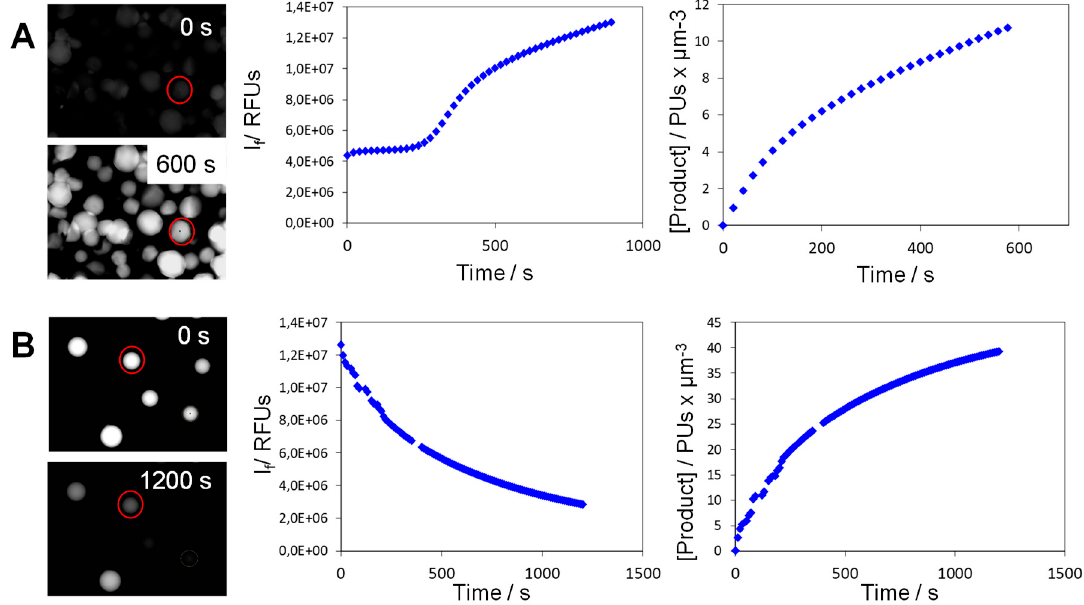
Figure 1. ( A ) Single-particle time courses extracted from microcopy images of agarose microbeads co-immobilizing formate dehydrogenase and NAD + . The reaction was triggered with 10 mM formic acid. ( B ) Single-particle time courses extracted from microscopy images of agarose microbeads co-immobilizing KRED and NADPH. The reaction was triggered with 10 mM of TFA. Left: microscopy images of initial and final times. Center: time-course of increasing ( A ) or decreasing ( B ) fluorescence intensity directly extracted from the time-frames of one bead-the region of interest (ROI). Right: Normalized progress curves of product volumetric concentration along the reaction time for the selected ROI (right micrographs). These plots are derived from the central plots that contain the raw data acquired from the microscope.